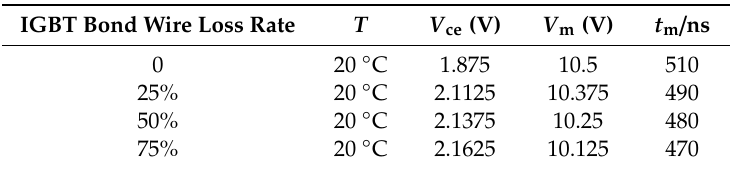
Table 6. Data before standardization.